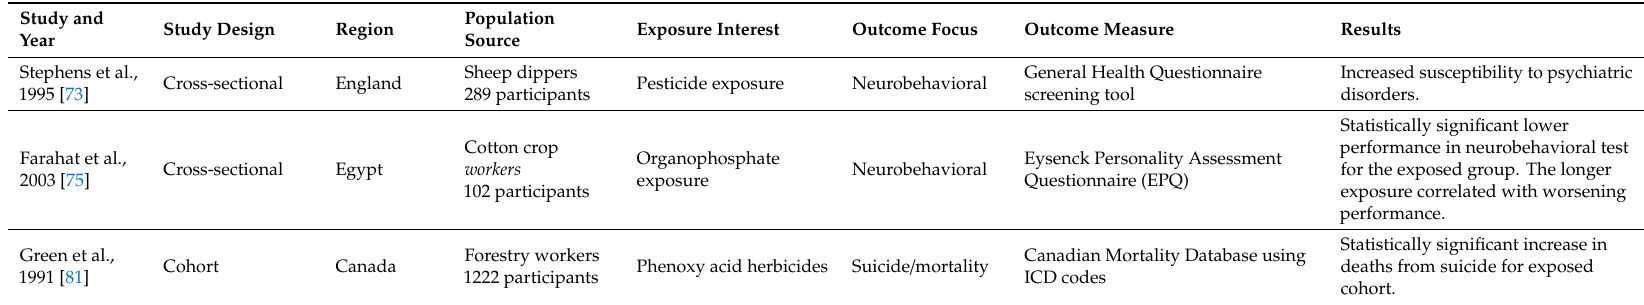
Table 2. Characteristics of the studies published on the e ff ects of low-dose pesticide exposure on mental health outcomes and the e ff ects of pesticide exposure on